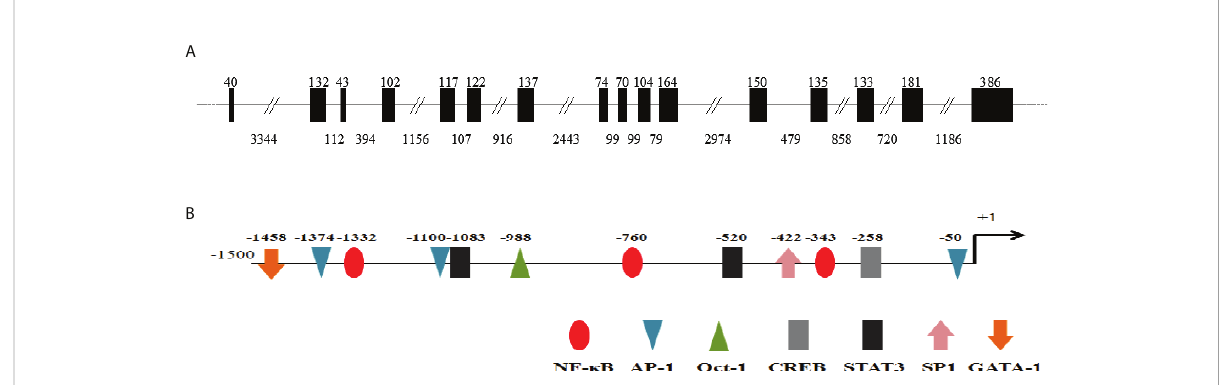
FIGURE 2 Genomic organization and 5 ′ fl anking regions of Ci MEKK3. (A) The intron-exon organization of Ci MEKK3. Exons and introns are indicated by black boxes and black lines with the corresponding sizes (bp), respectively. (B) Transcription factor binding sites in the 5 ′ fl anking regions (~1.5 kb) of Ci MEKK3. The predicted binding sites are shown by different colors of ellipses, triangles, arrows or